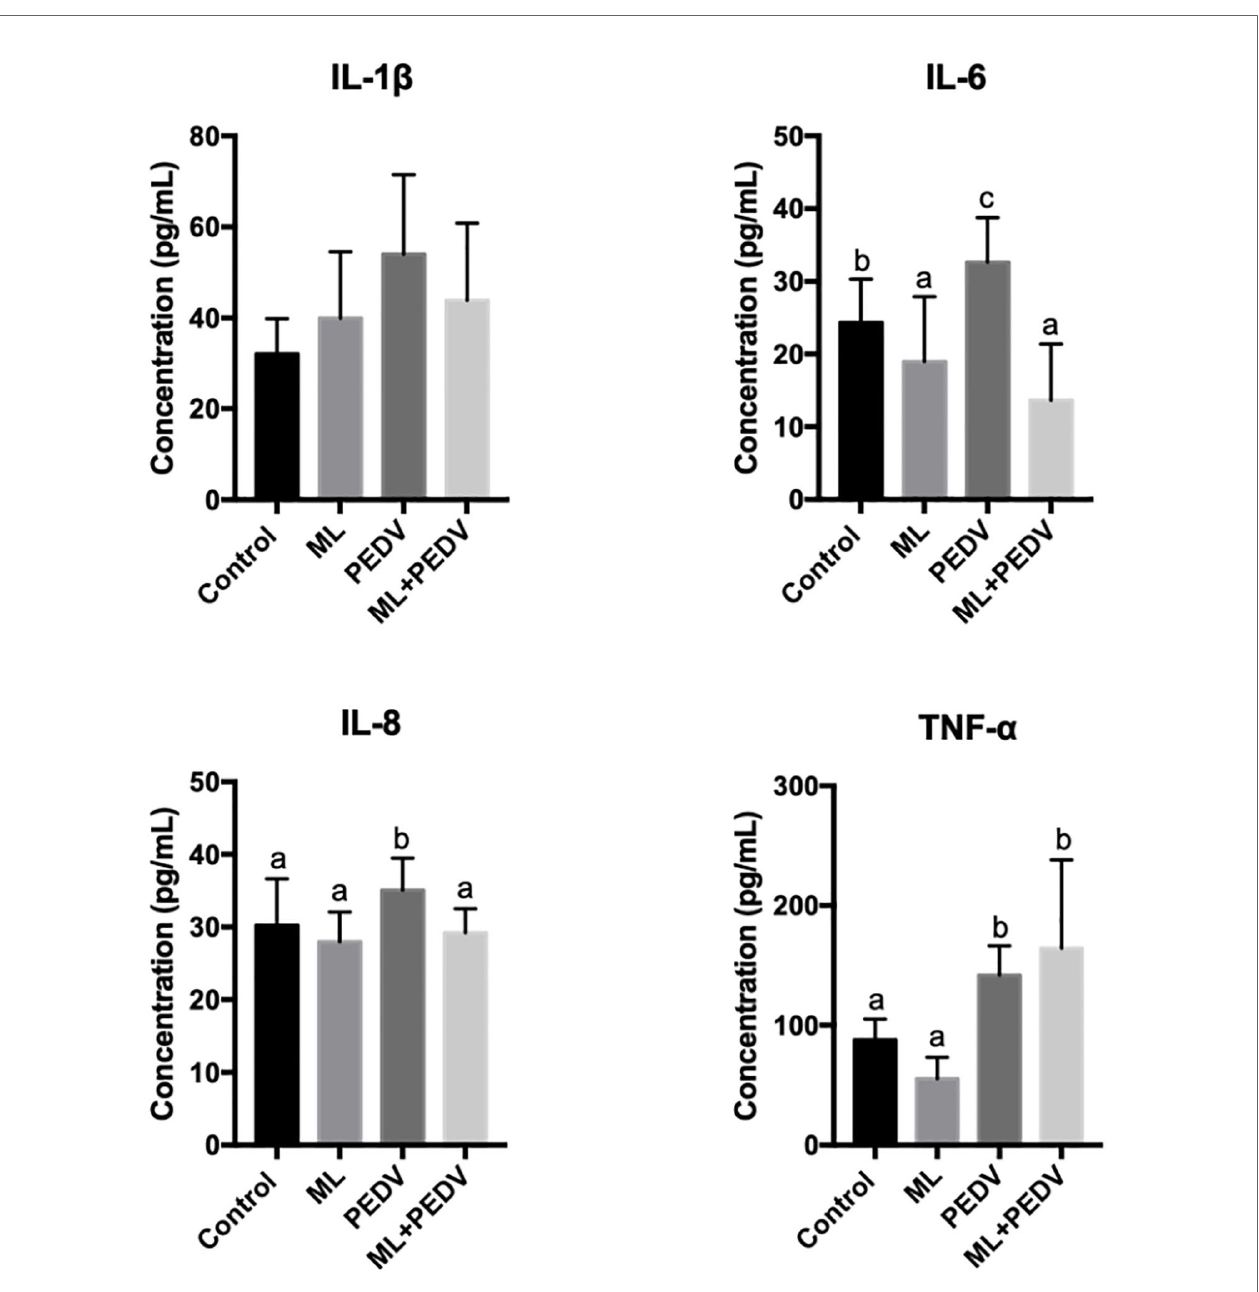
FIGURE 4 | Effects of ML administration on cytokine levels in piglets infected with PEDV. Bars not sharing a common lowercase letter differ signi fi cantly (p <